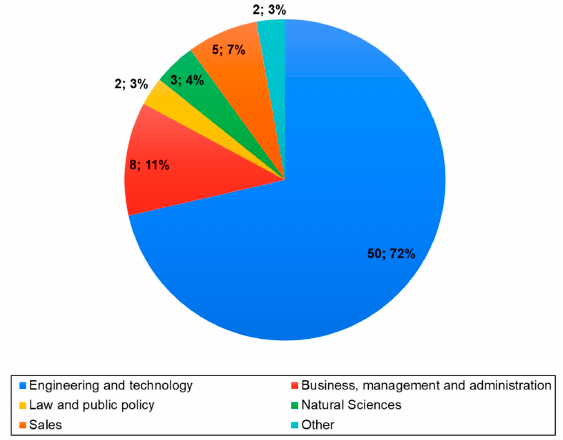
Figure A1. Professional field of the experts involved in the interview.